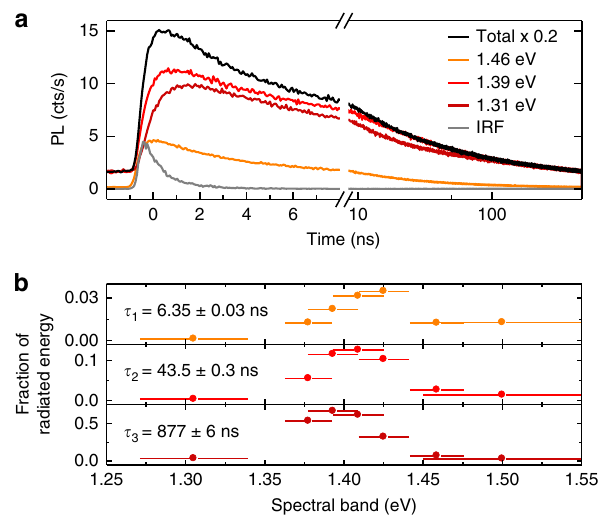
Fig. 2 a Confocal PL decay measured in different spectral bands of the HBL peak in Fig. 1. Decay traces are shown in different colors for three spectral bands centered at 1.46, 1.39, and 1.31 eV together with the total decay trace in black (scaled by ×0.2) and the instrument response function (IRF) in gray. The decay of the total spectrally un fi ltered PL was approximated best by three-exponential decay channels with time constants of ~6, 44, and 877 ns. b Relative contributions of the three decay channels in discrete spectral windows with central energies and widths represented by dots and bars, respectively. For each spectral window, the contributions were extracted from triple-exponential fi ts with decay constants fi xed to the characteristic timescales of the total HBL